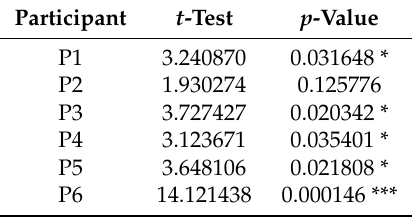
Table 4. Comparison of RG_SCORE in S1 and S9 for each exergame. Signicance levels: * for p < 0.05, ** for p < 0.01, *** for p < 0.001 Exergame t -Test p -Value Arm extension −